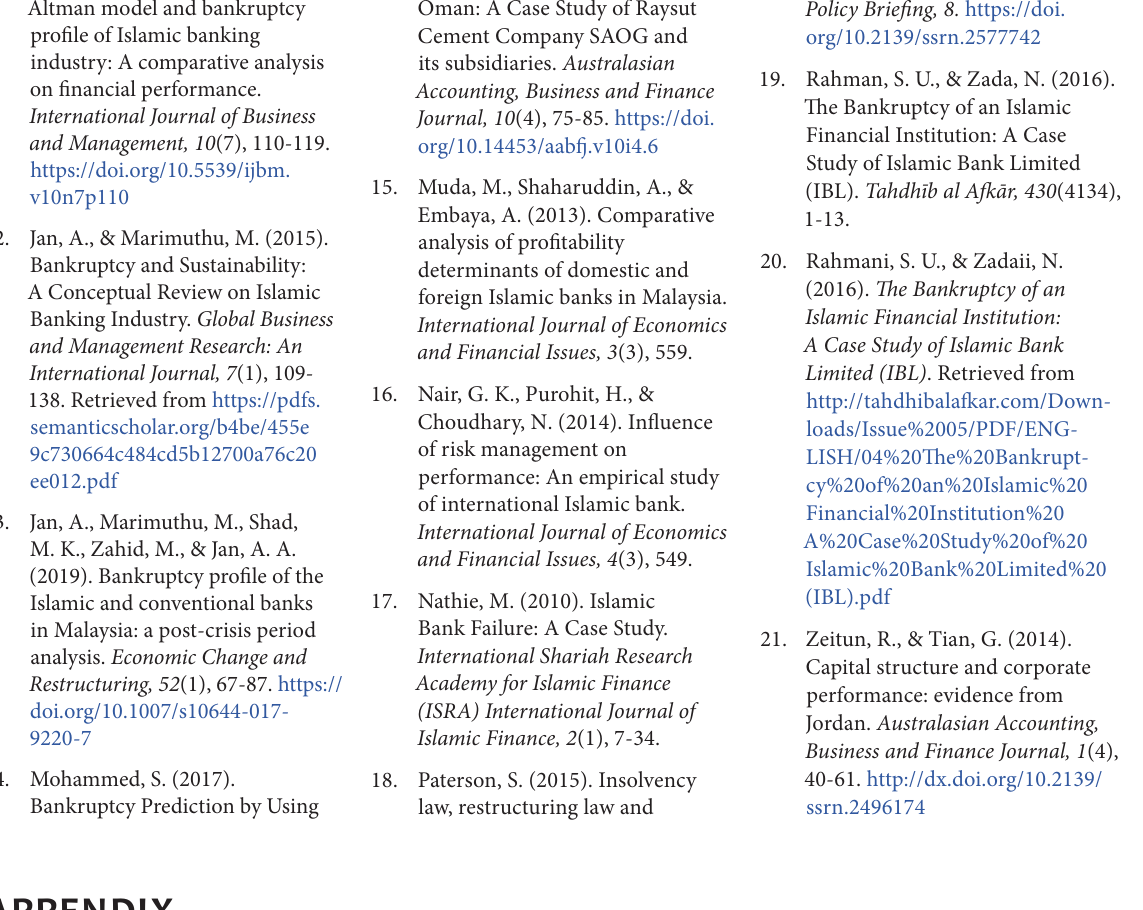
Table A1. Summary categories study position to reject or accept the hypothesis